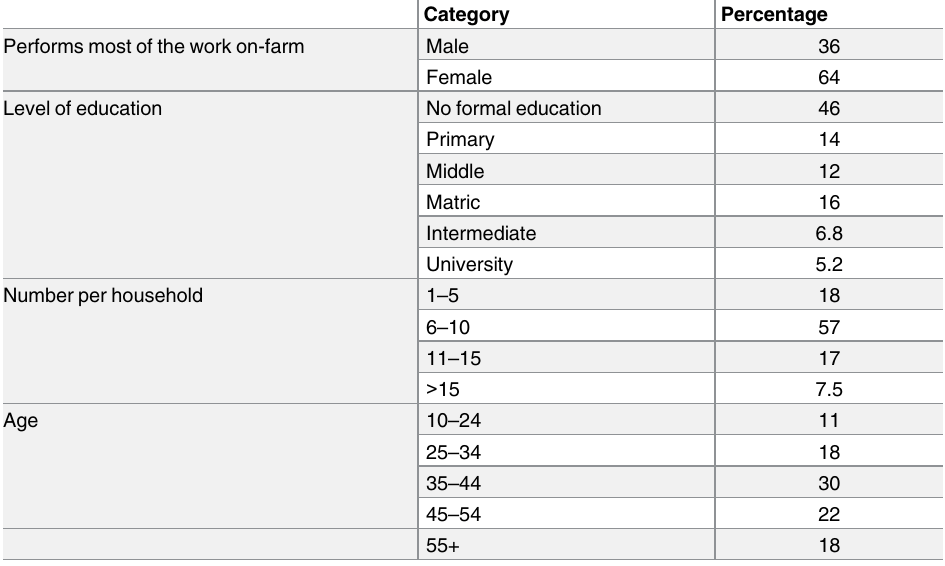
Table 3. Demographic features of smallholder dairy farmersof Pakistan participating in a cross-sec- tional study on brucellosis ( n = 420 farmers). Category Percentage Performs most of the work